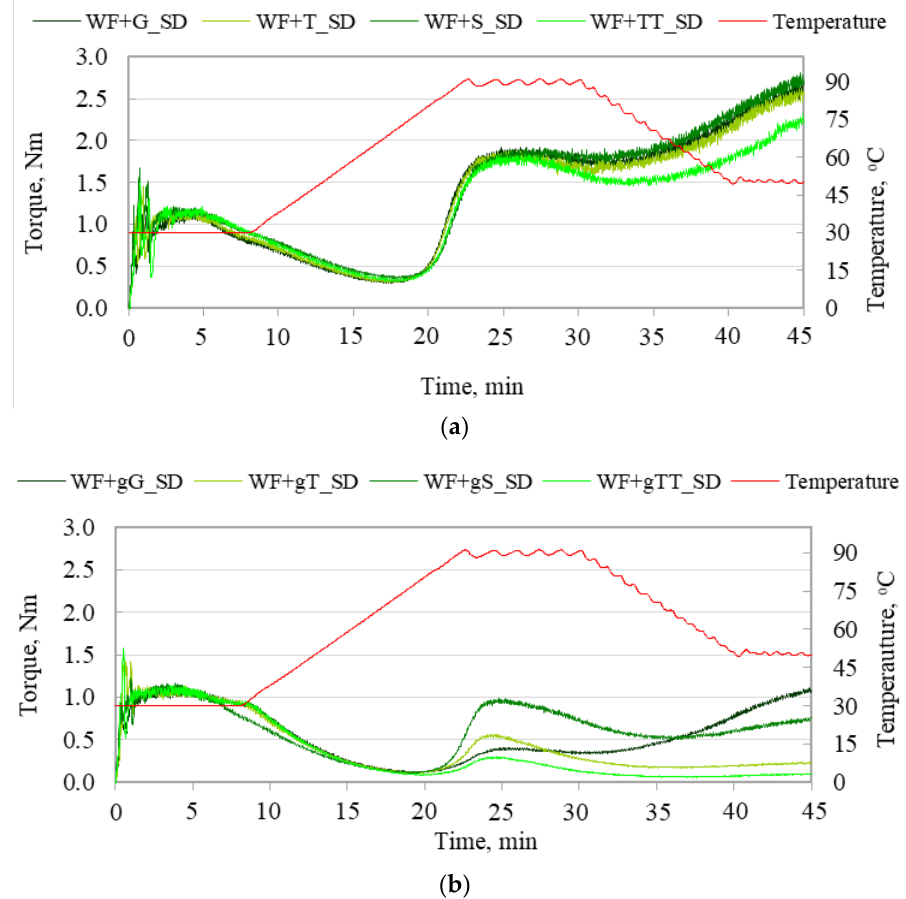
Figure 5. Mixolab curves of the white wheat flour (WF) supplemented with sourdoughs prepared with flours from ( a ) raw (G_SD, T_SD, S_SD and TT_SD) and ( b ) germinated grains (gG_SD, gT_SD, gS_SD and gTT_SD).